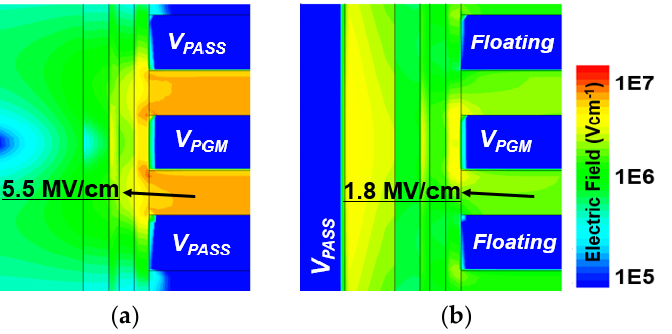
Figure 6. Electric field contour at t boosting in inhibited BL. ( a ) GAA and ( b ) GAAB NAND structure.